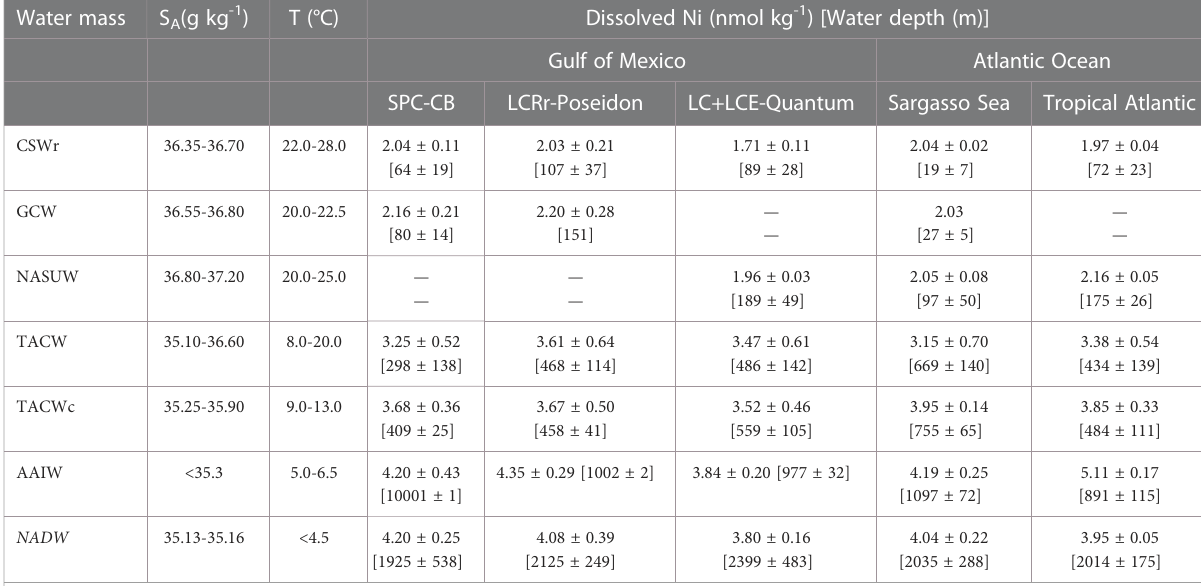
TABLE 1 Average concentration of dissolved Ni (± standard deviation) in the water masses detected in three contrasting regions of the Gulf of Mexico in terms of mesoscale dynamics during the XIXIMI-6 cruise. Water